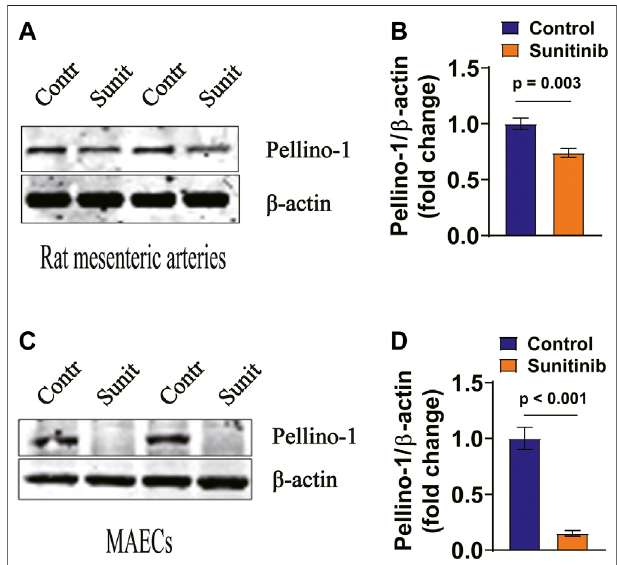
FIGURE 6 | Sunitinib inhibits Pellino-1 expression levels in rat arteries andMAECs. (A) RepresentativewesternblotimagesofPellino-1expressionin rat artery tissues dissected on day 7 from control rats or the rats-treated with sunitinib and bar graph represents Pellino-1 expression normalized to β -actin in rat arteries. (B) ( p (cid:2) 0.003 vs. control; n (cid:2) 6 rats per group). (C) Representative western blot images of Pellino-1 expression in control MAECs cells or in MAECs treated with 1 μ M sunitinib for 30 min. Statistic bar graph of Pellino-1 expression normalized to β -actin in MAECs, summarized from the datashown in. (D) ( p < 0.001vs. control; n (cid:2) 8batchesofcellsineach